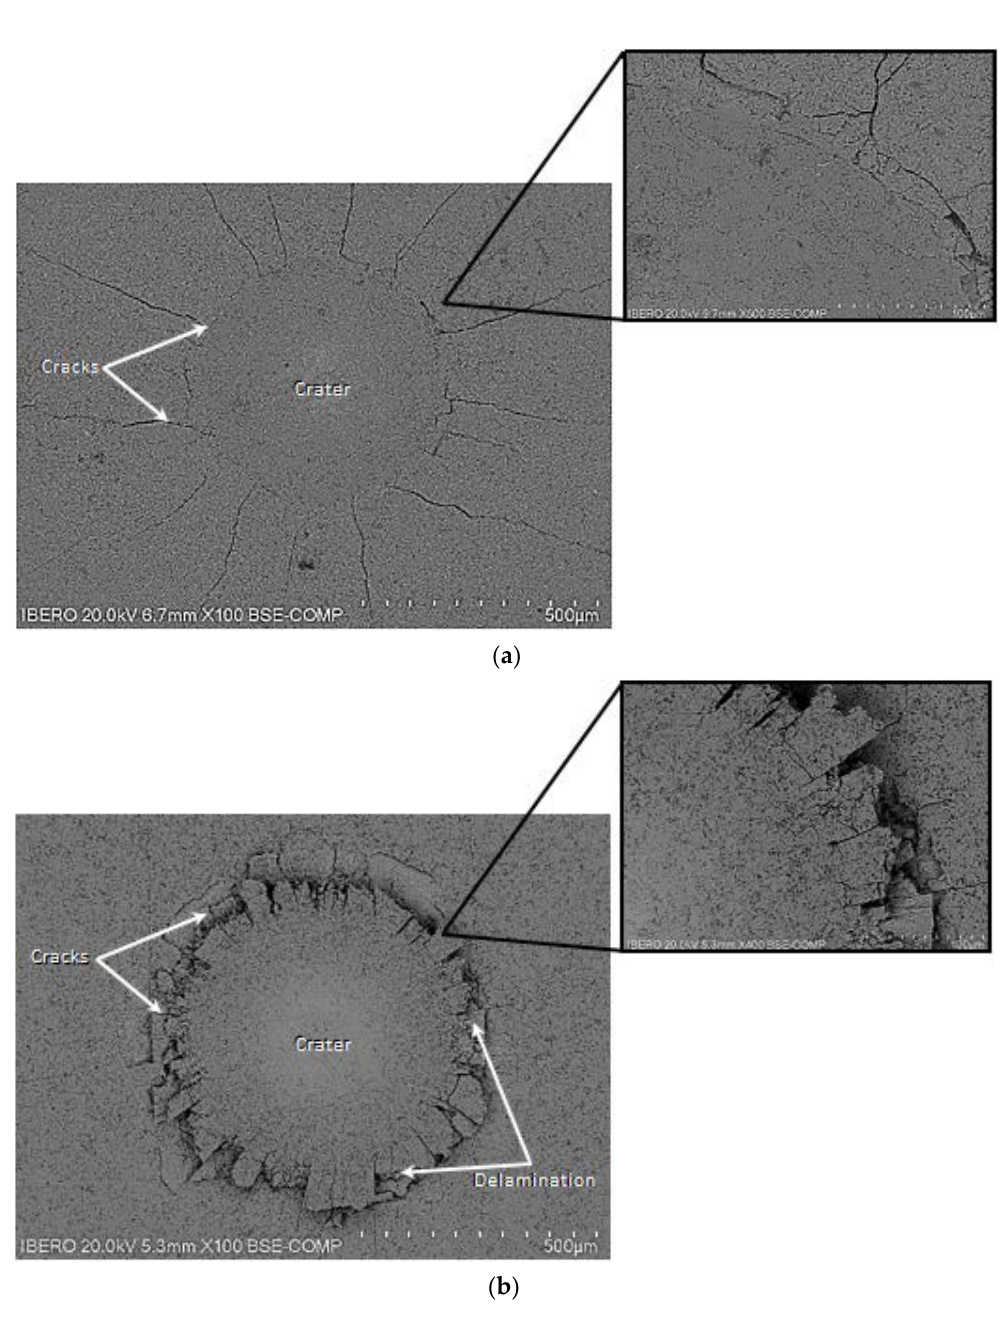
Figure 10. SEM micrographs of indented surfaces of treated ASTM A283 steel exhibiting the damage generated on layers formed for: ( a ) 2 h at 1123 K and ( b ) 8 h at 1273 K. generated on layers formed for: ( a ) 2 h at 1123 K and ( b ) 8 h at 1273